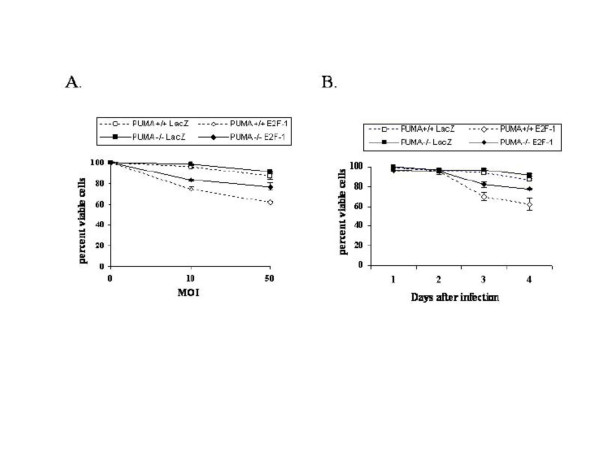
Resistance in response to E2F-1 expression in the HCT116 PUMA-/- cell line compared to the HCT116 PUMA+/+ cell line by cell viability assay. Both floating and adherent cells were harvested, counted, and scored at indicated time points. Viability was assessed using the trypan blue exclusion method. Results are expressed as the percent viable cells at each point and values represent the means ± SD (bars) of three independent experiments. A. HCT116 PUMA-/- and HCT116 PUMA+/+ cell lines were treated by infection with Ad-LacZ or Ad-E2F-1 at indicated MOI. The viability was assessed at day 4 after virus infection. B. Time course of cell viability of HCT116 PUMA-/- and HCT116 PUMA+/+ cells in response to Ad-LacZ or Ad-E2F-1 infection at MOI of 50.